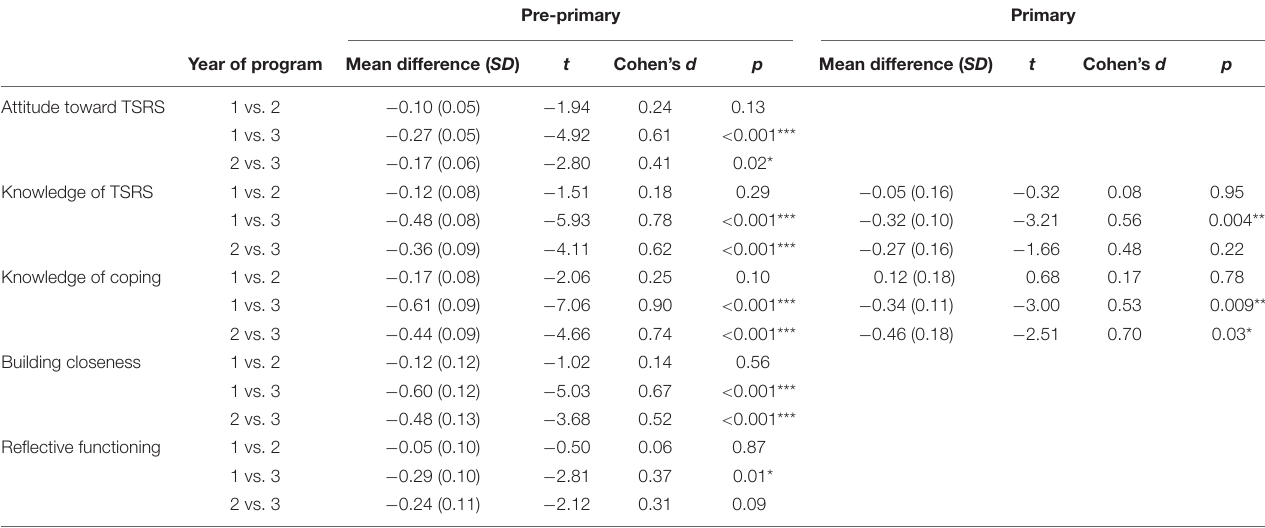
TABLE 14 | Post hoc comparisons for pre-primary and primary programs.